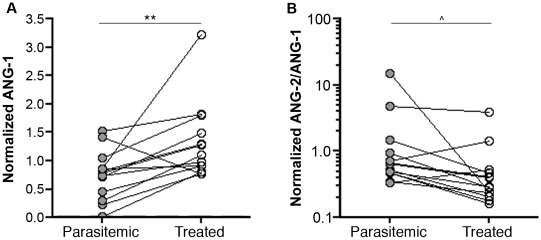
Angiopoietin-1 levels are increased upon resolution of peripheral parasitemia.Paired peripheral plasma (A) ANG-1 and (B) ANG-2/ANG-1 levels of primigravid women at consecutive visits: the first, when parasitemic by peripheral blood smear microscopy, and the next, when successfully treated and blood-smear negative. To account for physiological variation in angiopoietin levels with gestational age, values were normalized to mean value of aparasitemic controls at the corresponding gestational age. n = 13 pairs. ** P<0.01, ∧
P>0.05 (paired t-test).